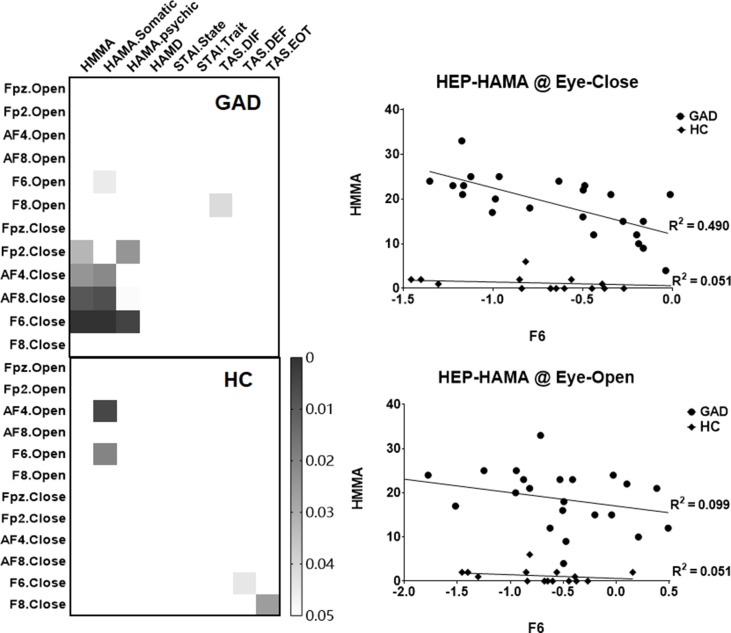
Heat maps and scatter plots of the correlation analyses. The left panel highlights the significant correlation (p < 0.05, uncorrected), and the right panel illustrates the relationship between the mean amplitude of HEP (at F6 electrode across four conditions) and the HAMA scores.